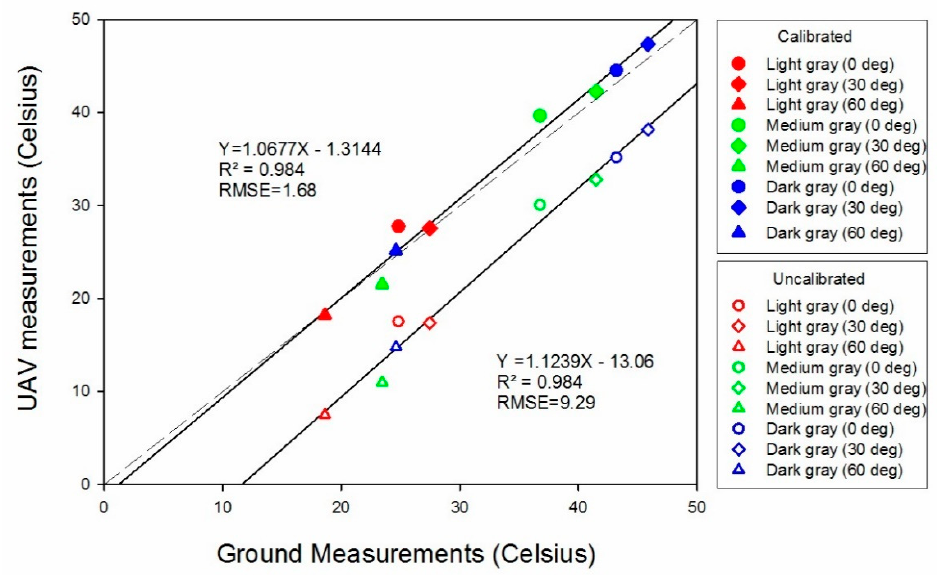
Figure 8. Accuracy assessment results of the unmanned aerial vehicle (UAV)-based temperature estimates based on the temperature-controlled references. Table 1. Temperature errors between the un-calibrated and calibrated data with temperature- controlled